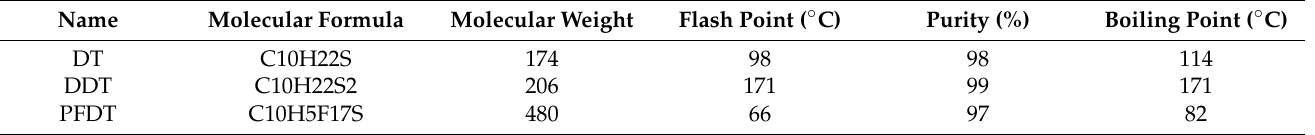
Table 1. The basic attribute parameters of three kinds of reagents.